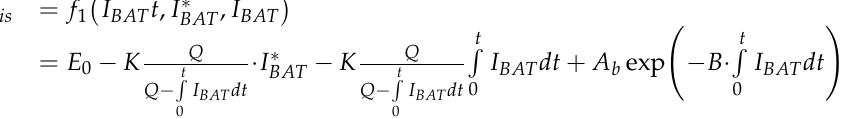
Figure 4. BAT Figure 4. BAT model.